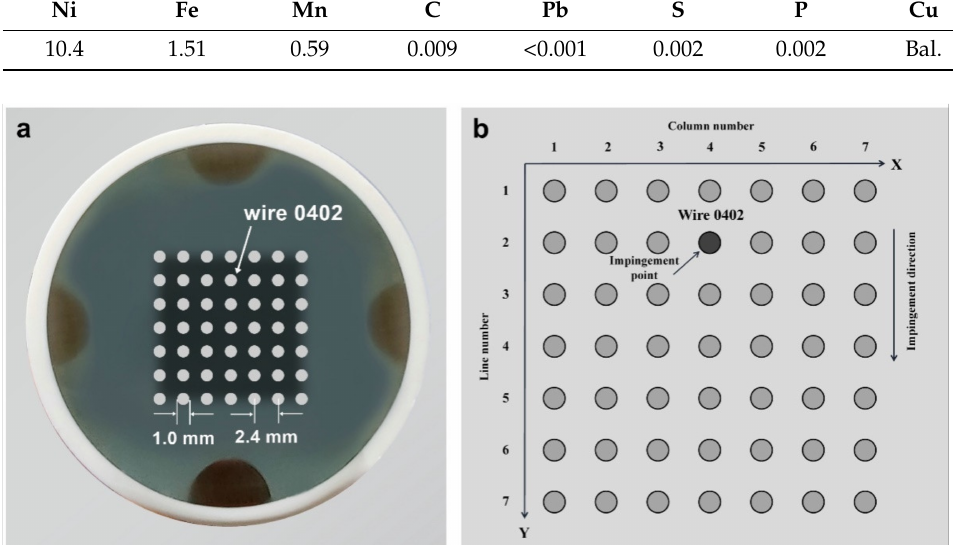
Figure 1. ( a ) Image and ( b ) coordinate system of wire beam